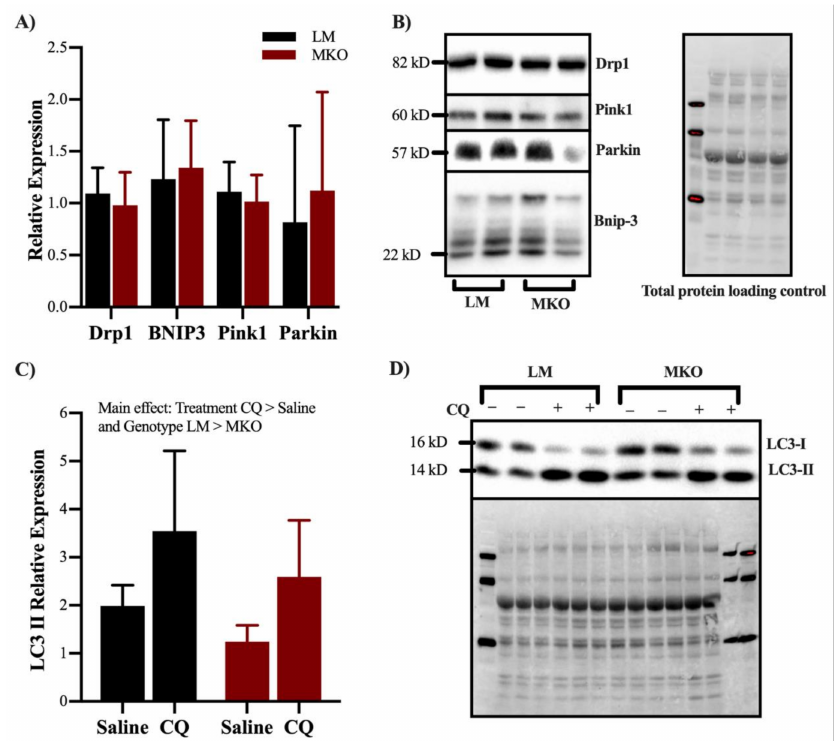
Figure 6. Effect of Ulk1 deficiency on markers of mitochondrial remodeling. ( A ) Relative expres- sion of mitophagy related proteins DRP1, BNIP3, Pink1, and Parkin ( p > 0.05), ( B ) Representative immunoblot panel ( C ) Relative expression of LC3II in middle aged mice treated with Choloroquine or saline as a control (Main effect of Treatment and Genotype p = 0.0007 and p = 0.0341, respectfully). ( D ) Representative immunoblots of LC3. All data are presented as mean ±